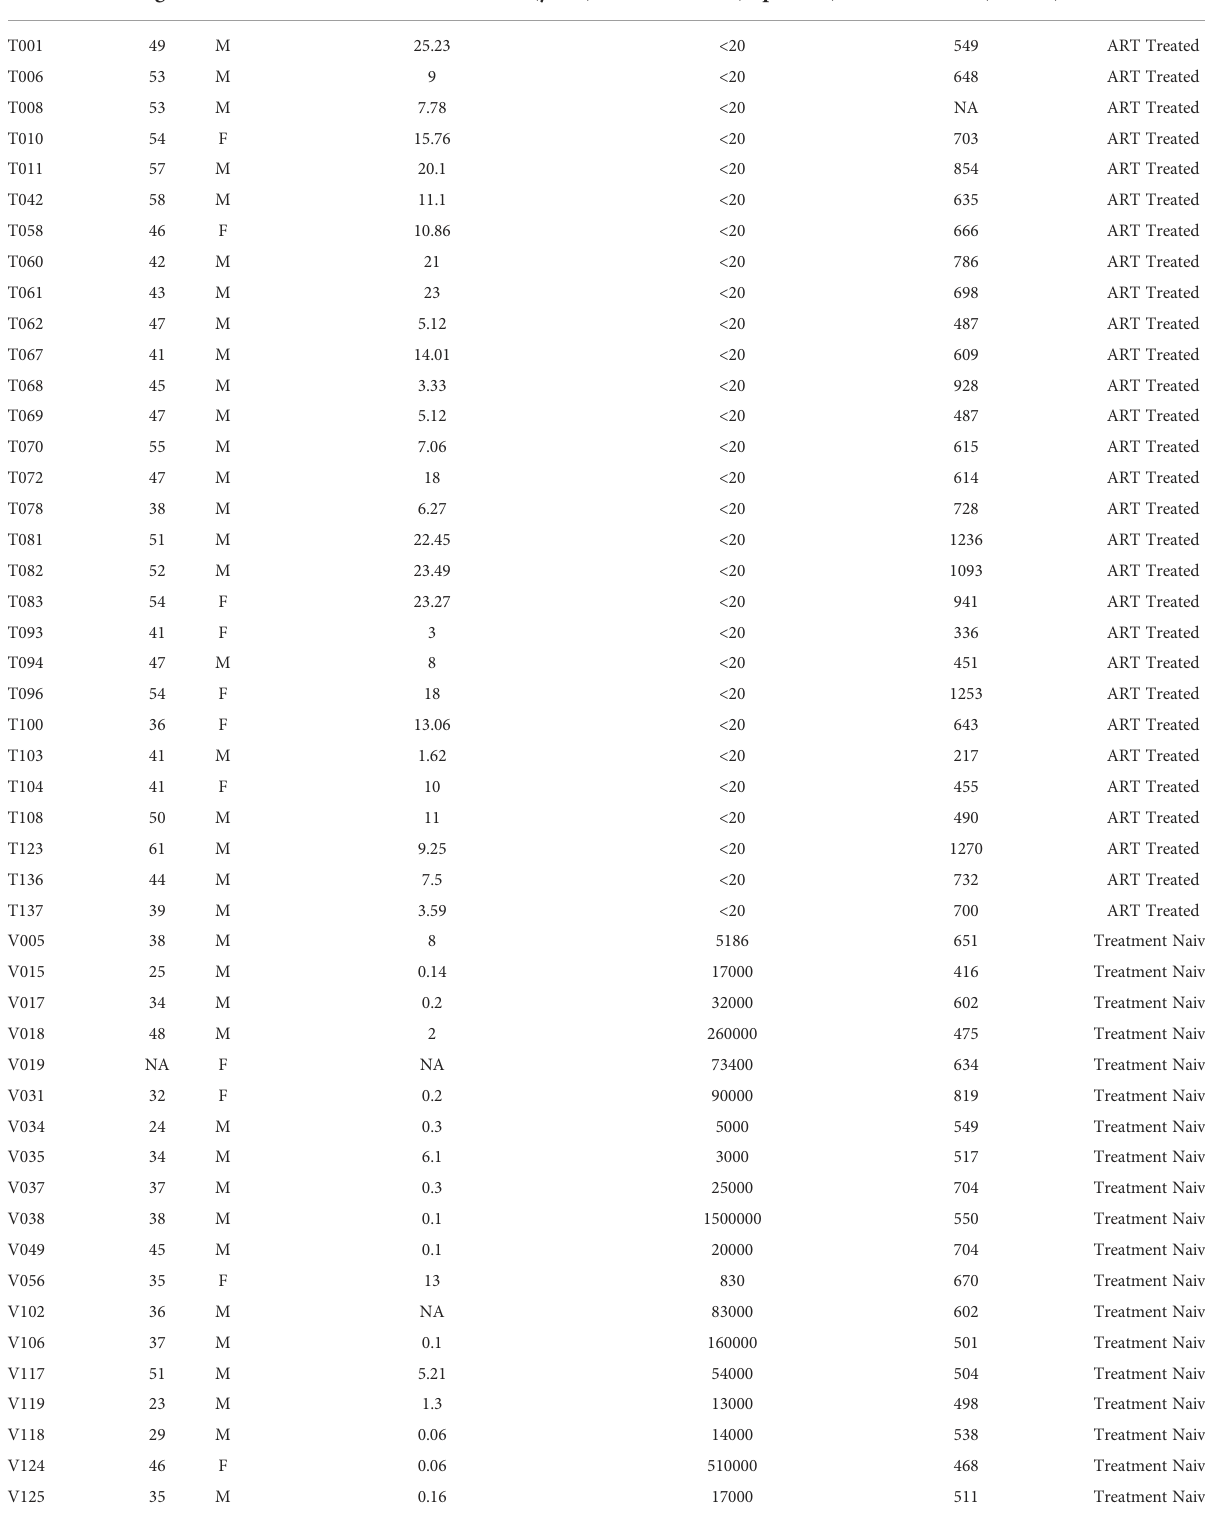
TABLE 1 Study cohort: clinical